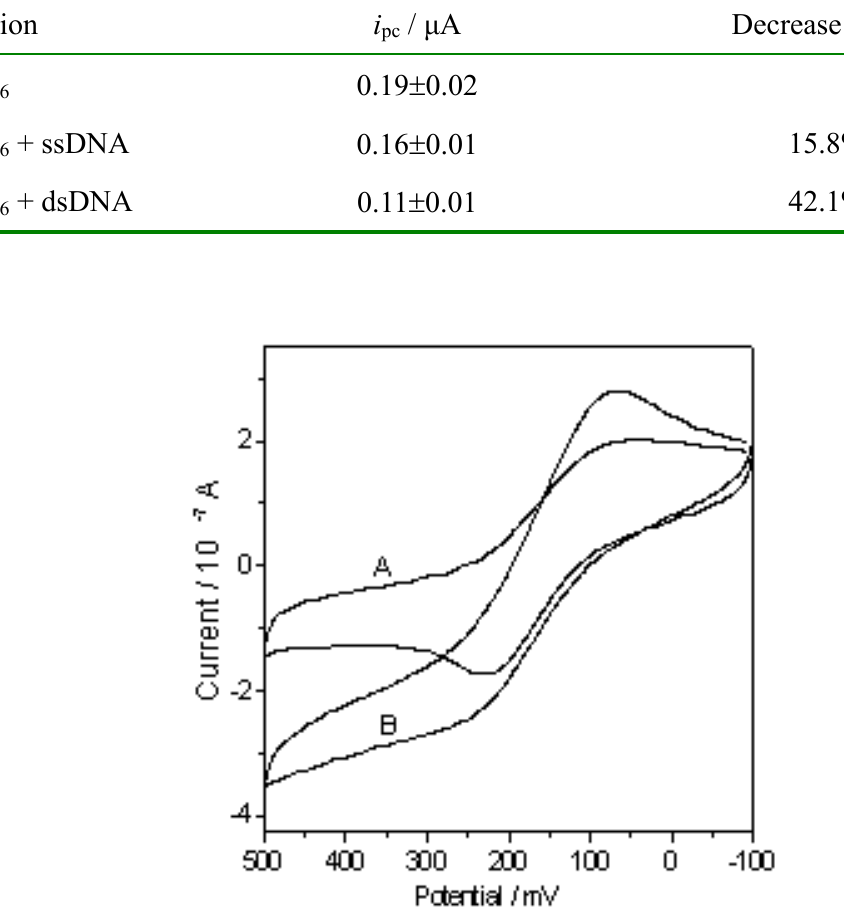
at ssDNA/SAM/Au (A) and 6 at Au, SAM/Au, ssDNA/SAM/Au and 6